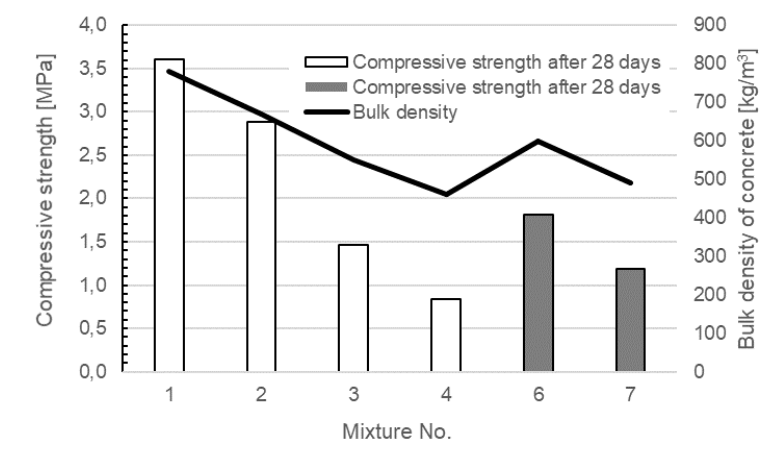
Figure 3. Compressive strength and bulk density of hardened lightweight concrete.